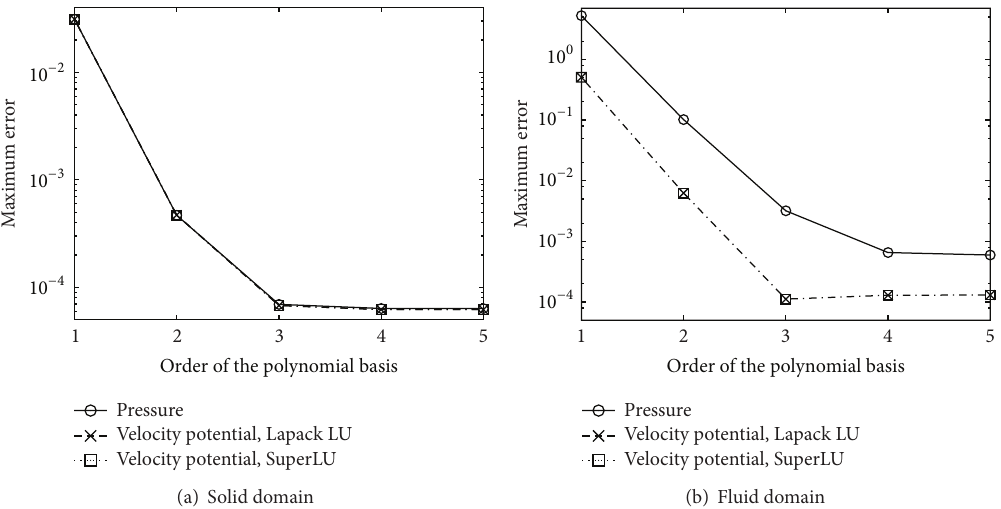
Figure 3: Maximum errors, computed as 𝐿 ∞ -norms, with respect to the element order. The number of time steps is fixed to be 400, and square-element meshes with mesh step size ℎ = 0.1 are used in both media.